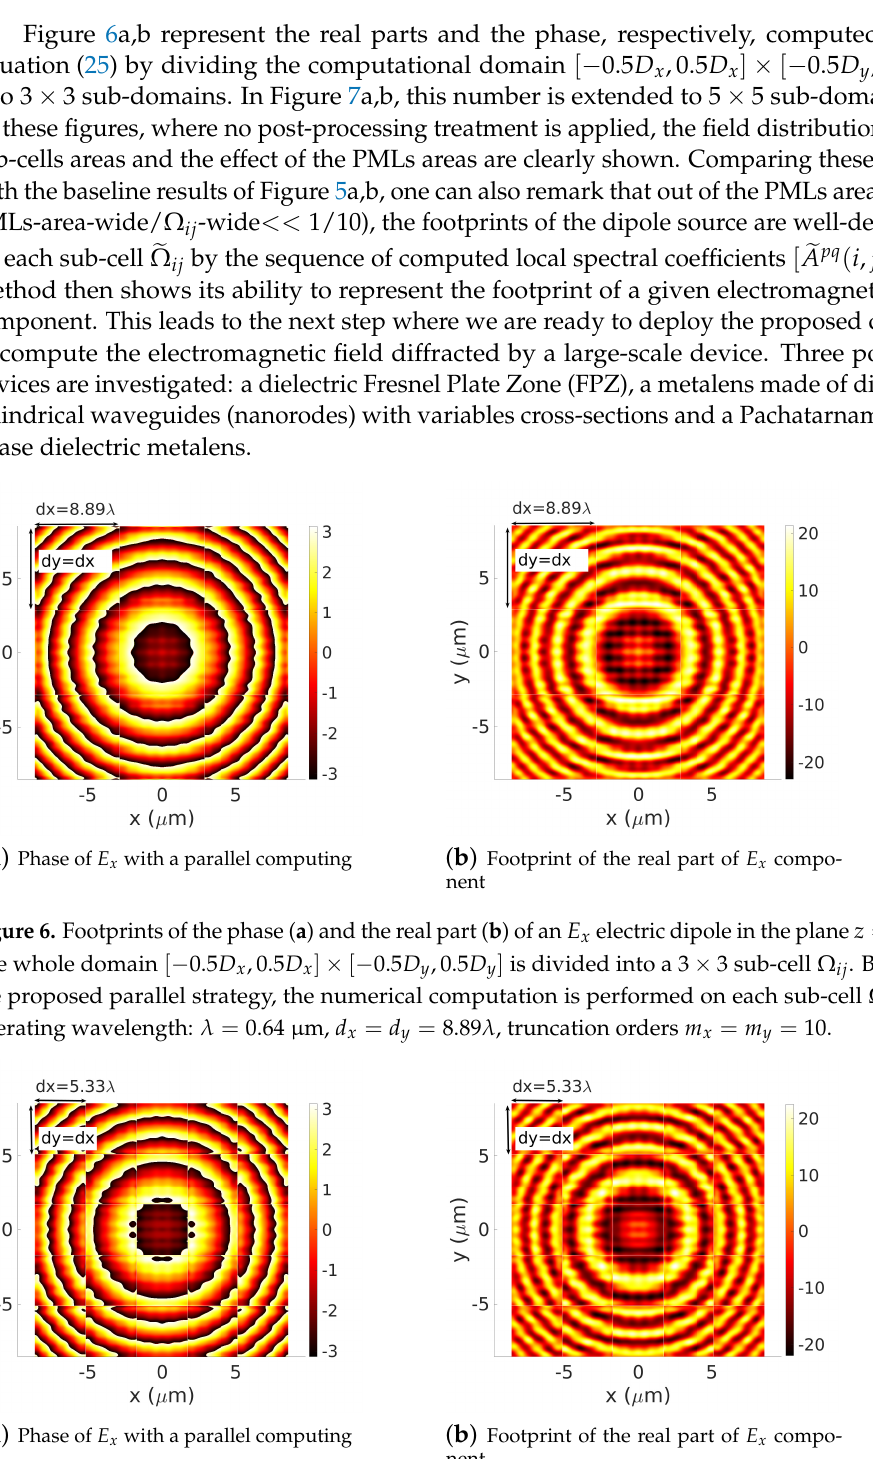
Figure 7. Footprints of the phase ( a ) and the real part ( b ) of an E x electric dipole in the plane z = − 20 λ . The whole domain [ − 0.5 D x ,0.5 D x ] × [ − 0.5 D y ,0.5 D y ] is divided onto a 5 × 5 sub-cell Ω ij . The operating wavelength: λ = 0.64 µ m, d x = d y = 5.33 λ , truncation orders m x = m y =